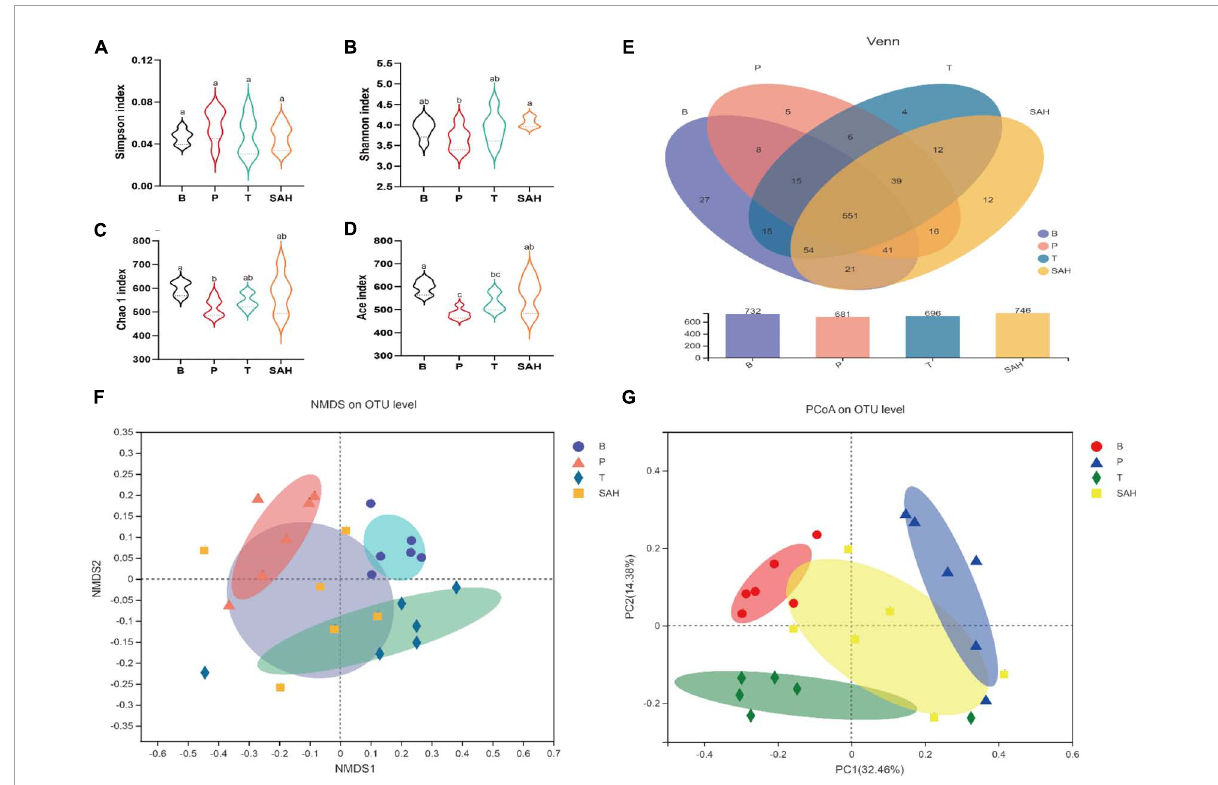
FIGURE6 Sciadonic acid (SA) relieved gut microbiota disturbances caused by type 2 diabetes mellitus (T2DM). (A) Simpson index, (B) Shannon imdex, (C) Chao 1 index, (D) ace index, (E) venn diagram, (F) NMDS, and (G) PCoA analysis diagram. Data were presented as the mean ± SD ( n = 6). Different letters represent a significant difference among multiple groups ( P < 0.05). B, control group; P, diabetic model group; T, (HFD + 200 mg kg – 1 Met); SAH, (HFD + 280 mg kg – 1